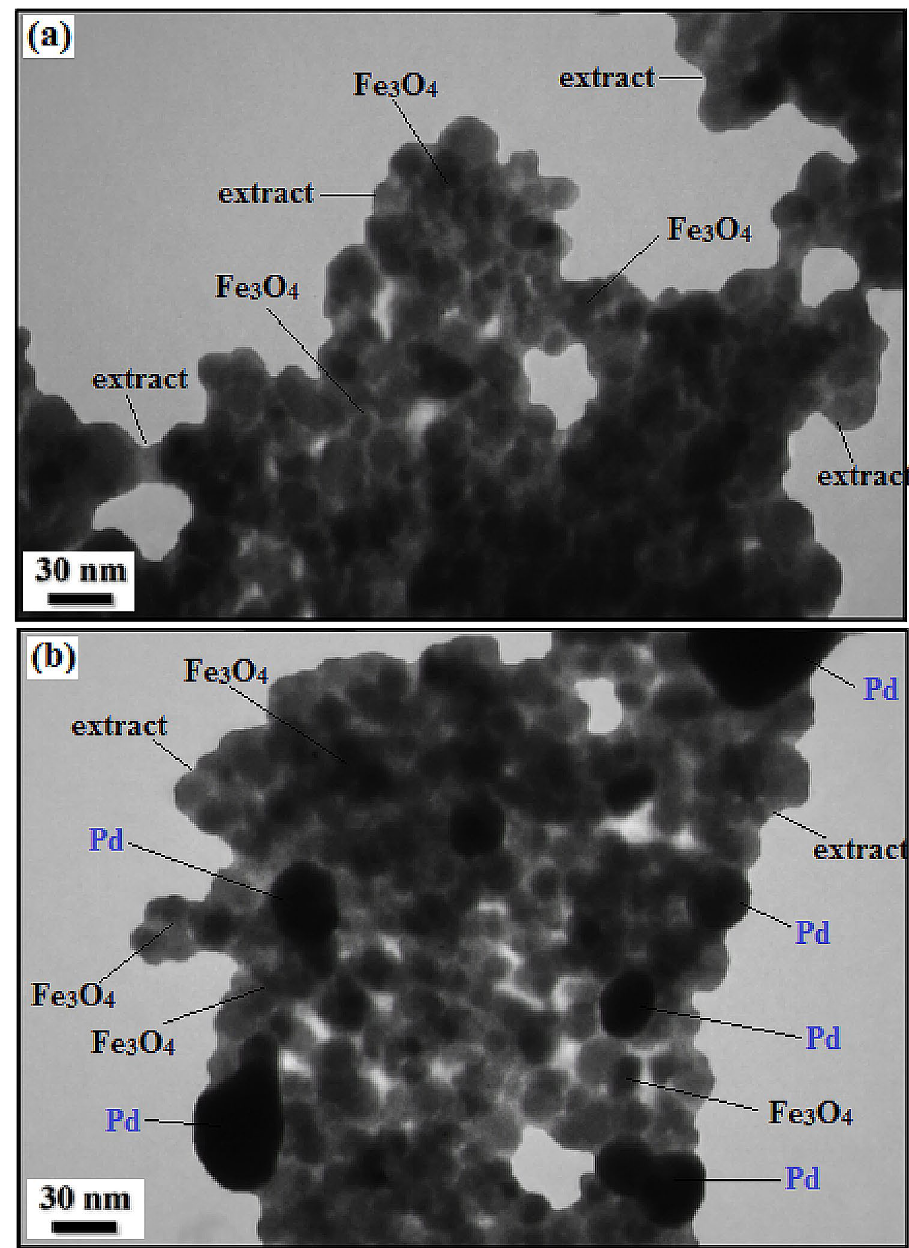
Figure 6. TEM images of ( a ) Fe 3 O 4 @ Fritillaria NPs and ( b ) Fe 3 O 4 @ Fritillaria /Pd